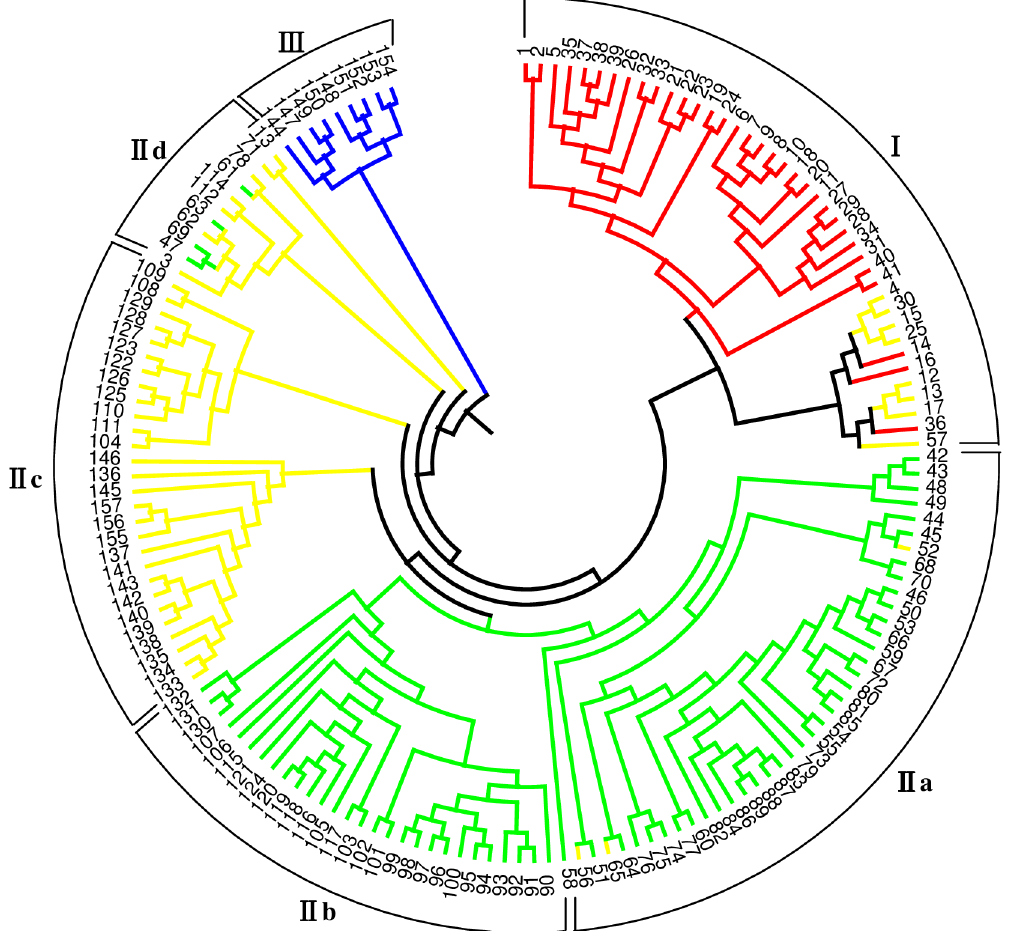
Fig 3. Unweighted pair-group method of arithmetic averages(UPGMA) dendrogram generatedfrom SRAP data showing relationships of 157 bermudagrass accessions. Colors in the dendrogram correspond to populationstructure as identifiedin structure analysis. Each color represents one subgroup(subgroupC1 = red; C2 = green; C3 = blue, Mixed = yellow).